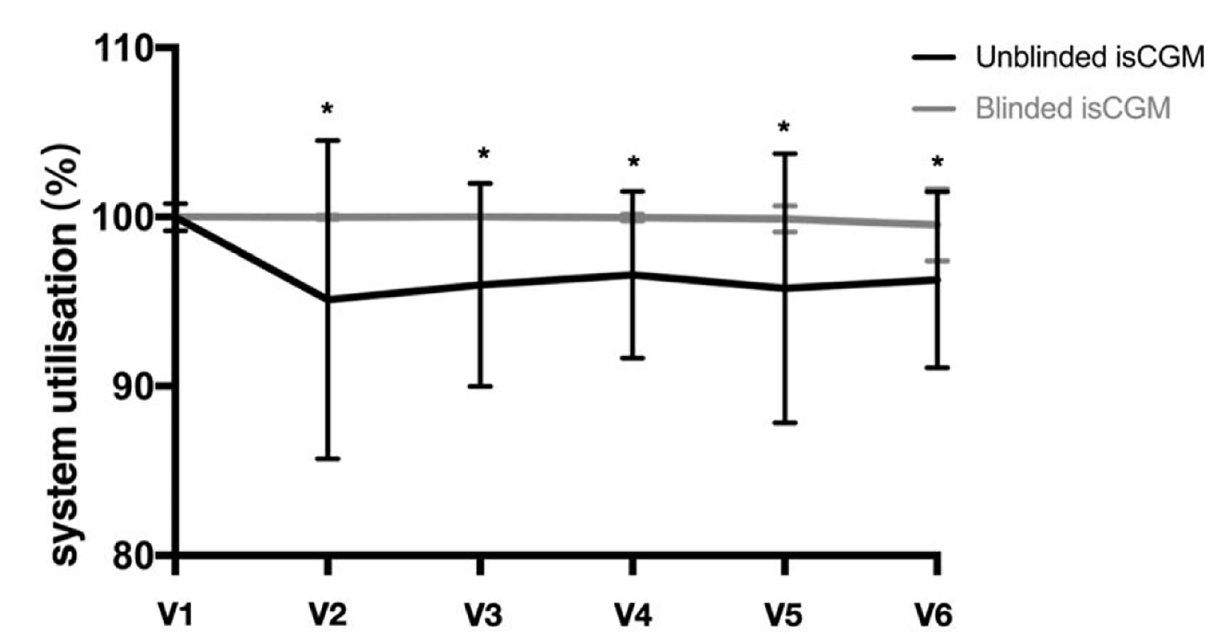
FIGURE 3 Glucose monitoring system utilization in a study of the ef fi cacy of unblinded and blinded intermittently fl ash continuous glucose monitoring on glycemic control in adults with type 1 diabetes.*P<0.05 between unblinded isCGM and blinded